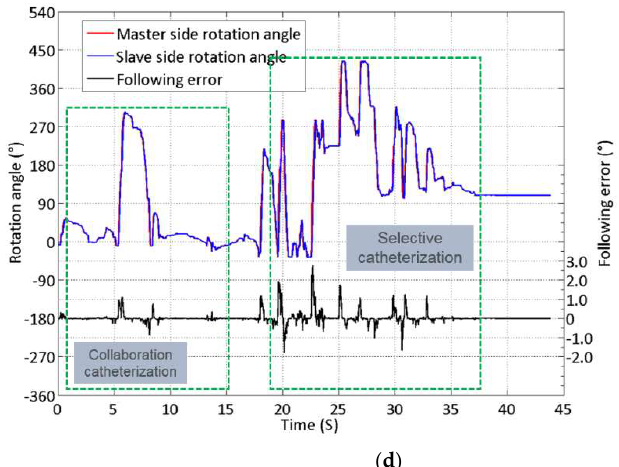
Figure 13. Linear motion, rotational motion result, and the following error of the catheter and guidewire. ( a ) Linear motion result and the following error of the catheter. ( b ) Linear motion result and the following error of the guidewire. ( c ) Rotational motion result and the following error of the catheter. ( d ) Rotational motion result and the following error of the guidewire.